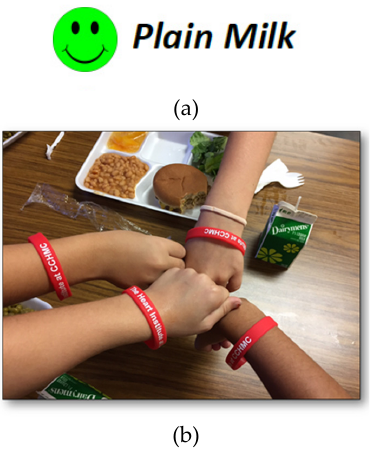
Figure 1. Emoticon example and students wearing “kick off bracelets” by a Power Plate (PP): ( a ) Plain Milk Emoticon; ( b ) Students wearing bracelets by PP. Milk Emoticon; ( b ) Students wearing bracelets by